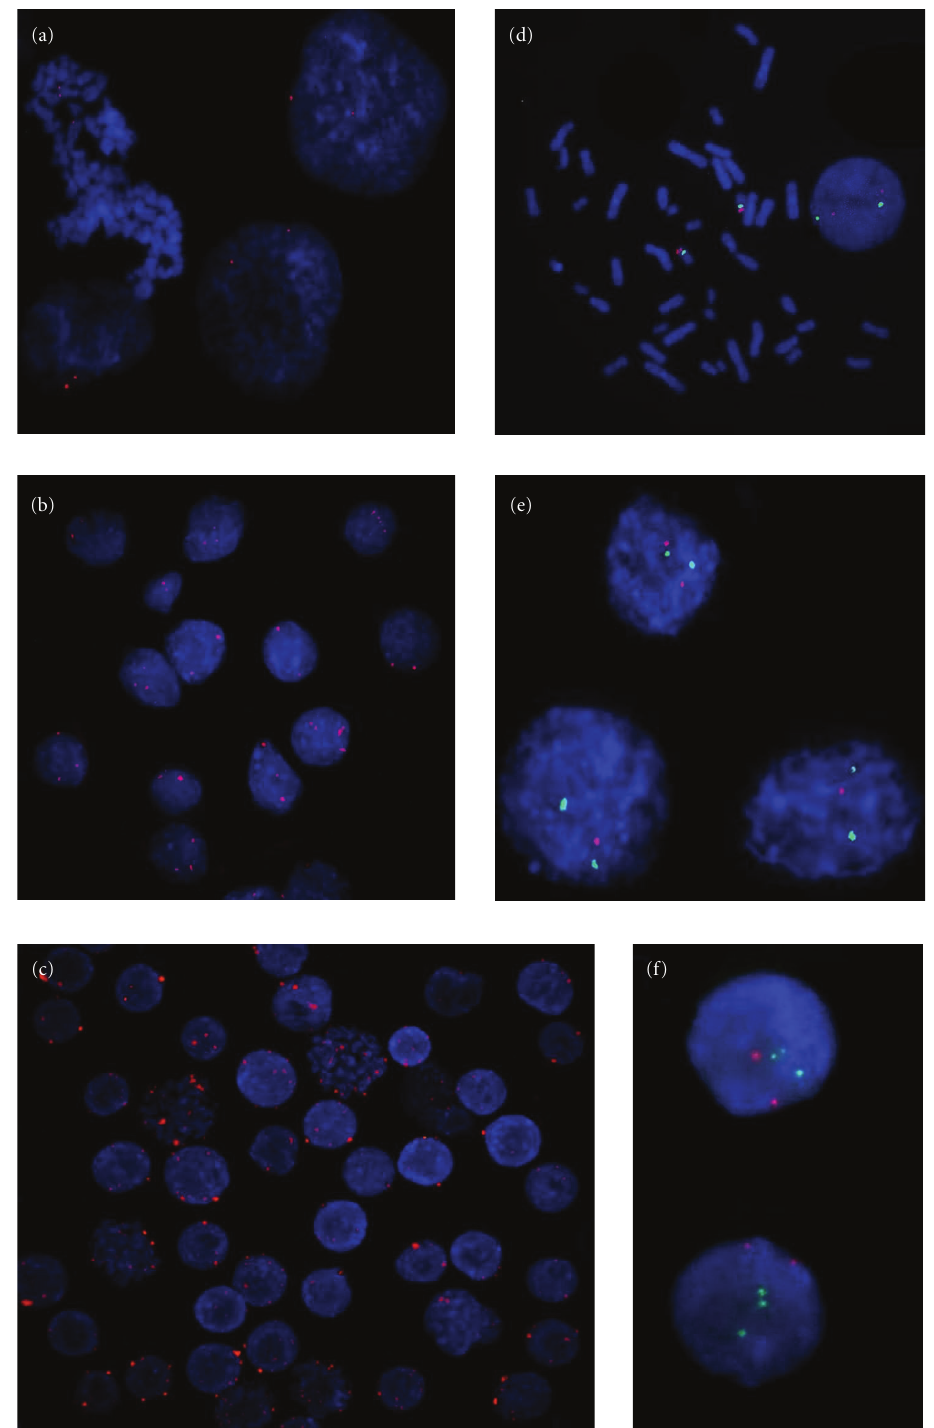
Figure 1: Fluorescence in situ hybridization assay. (a) Interphase nuclei presenting two MYC signals from normal gastric mucosa; (b) interphase nuclei presenting 2–5 MYC signals from ACP02 parental primary tumor; (c) interphase nuclei presenting MYC signal number alterations, including high amplification, from the 85th passage of AGP01 cell line; (d) interphase and metaphase cells presenting two copies of chr17/ TP53 from lymphocytes control, with the green spots representing the 17 centromere probe and the red representing the TP53 gene probe; (e) interphase nuclei presenting two signals of chr17 and two or one TP53 signal(s) from ACP02 parental primary tumor; (f) interphase nuclei presenting three signals for chr17 and two TP53 signals from the 85th passage of ACP03 cell